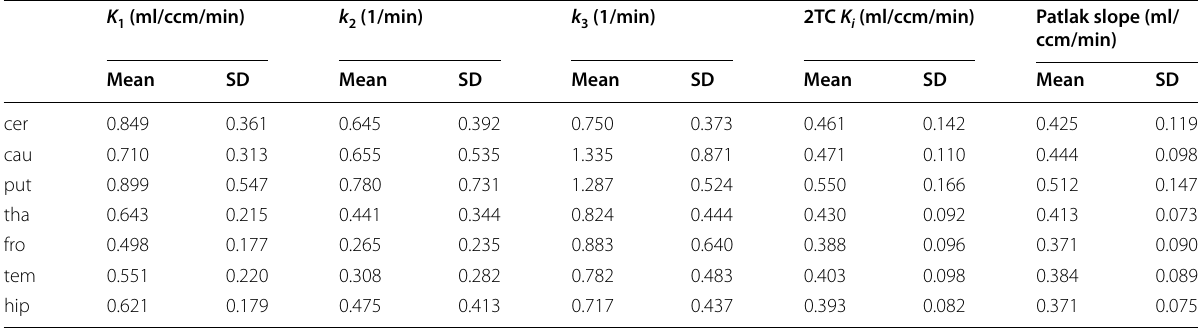
by 2TC and Patlak slope i